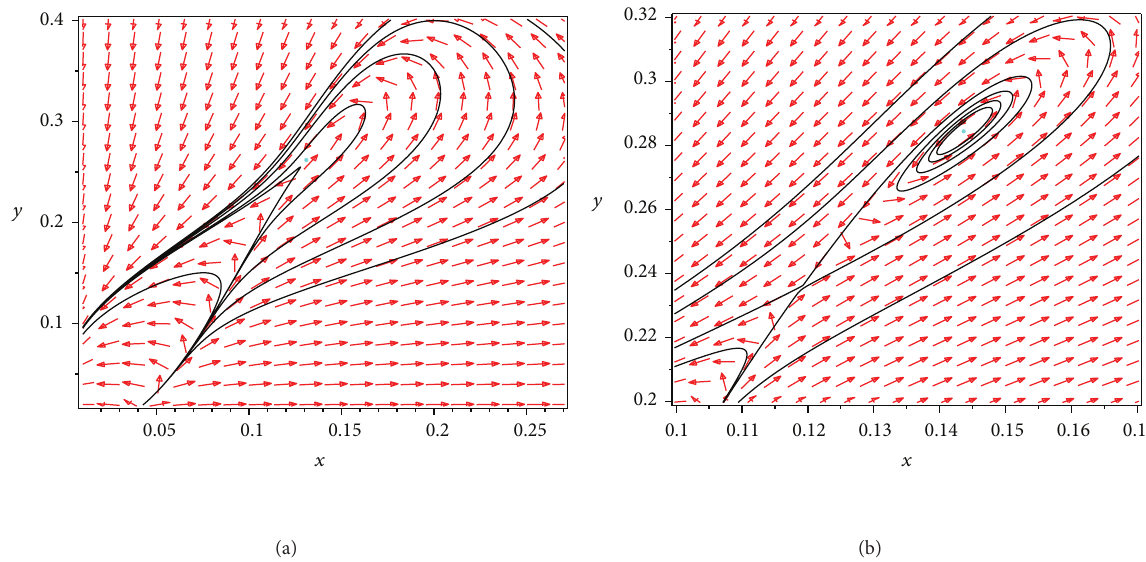
Figure 4: (a) System (4) shows a cusp of codimension 2 when 𝑎 = 1.6 , 𝛽 = 2 , 𝑚 = (1/4)(1 − 𝛽/(𝑎𝛽 + 1)) , ℎ = (1/4)(𝛽/(𝑎𝛽 + 1) − 1) 2 + 𝑚𝛽/(𝑎𝛽 + 1) , 𝛿 = 1/(𝑎𝛽 + 1) 2 , and 𝜇 when 𝜇 1 = −0.0132 , 𝜇 2 = −0.02 .